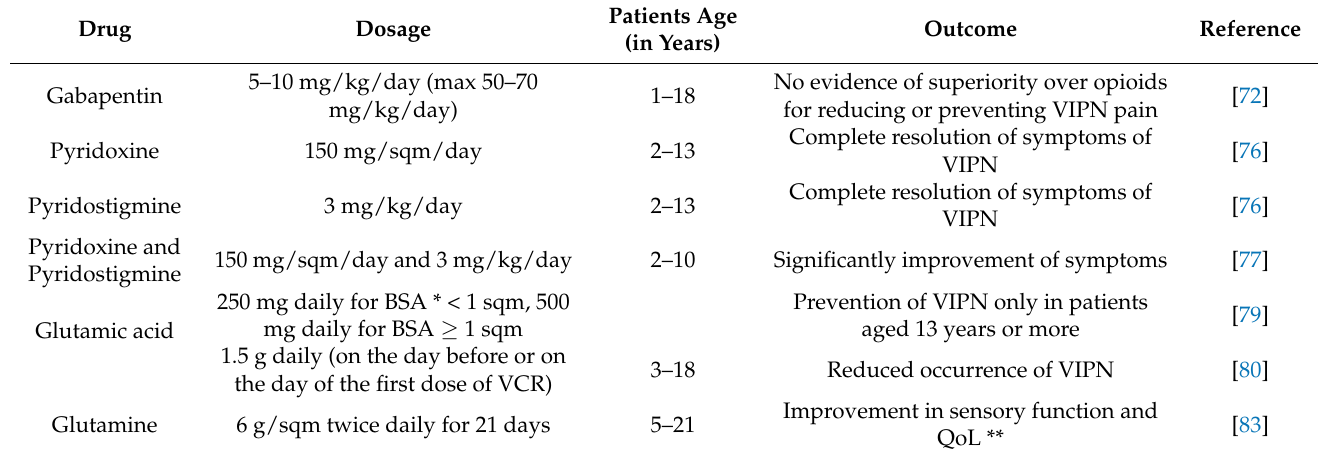
Table 2. Principal drugs investigated for prophylaxis and treatment of VIPN in